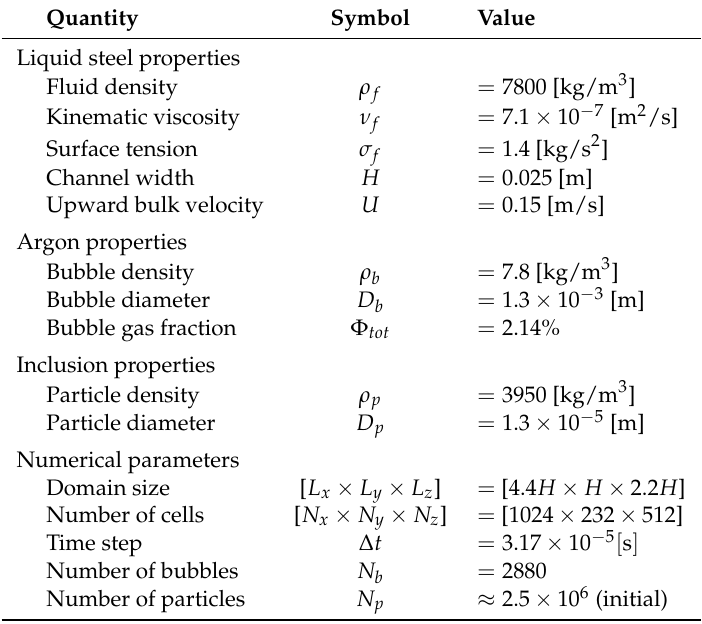
Table 2. Physical and numerical parameters of the channel flow